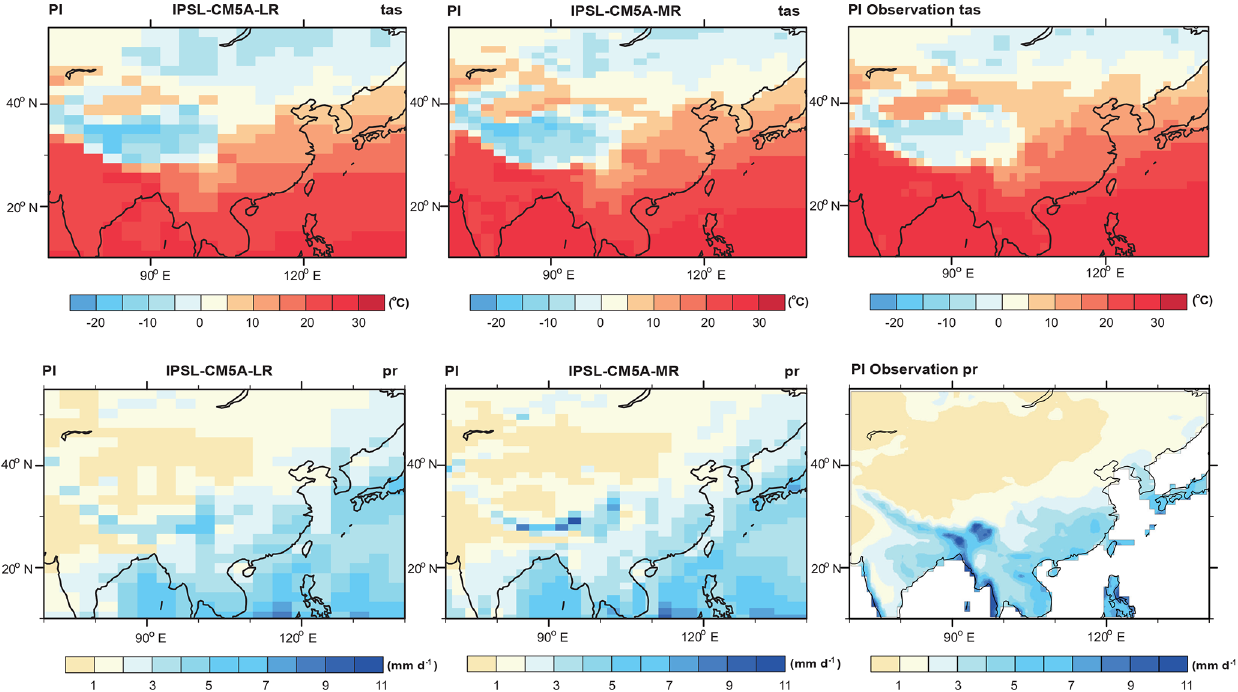
Figure 9. The pre-industrial climate comparison between simulations and observations. “Tas” means temperature 2m above the surface, and “pr” means